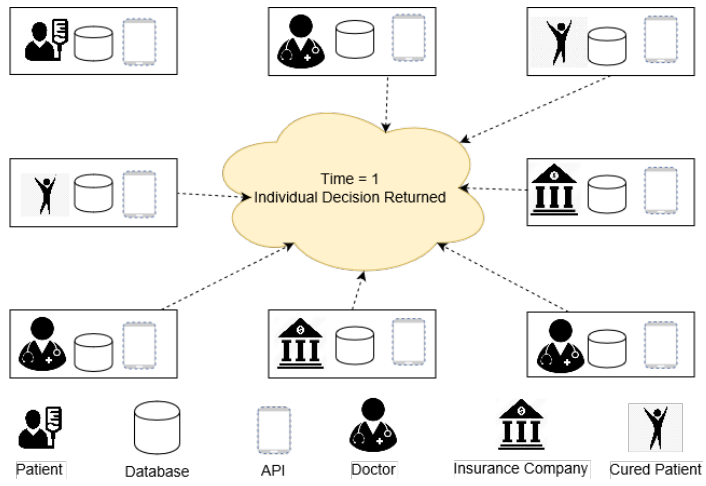
Figure 9. At time 1: Individual decision returns to PoF.